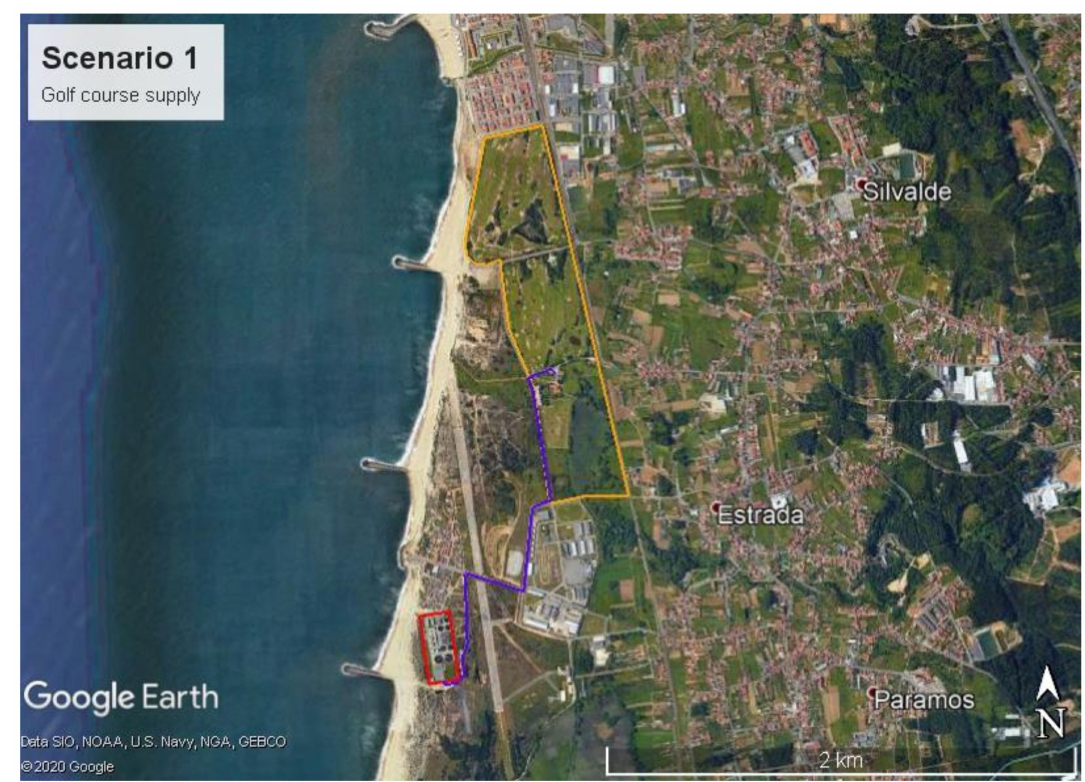
Figure 5. Scenario 1: WtR supply, provided by Espinho WWTP (in red), by pressurized network (pipe in blue) to the Oporto Golf Club bordered in